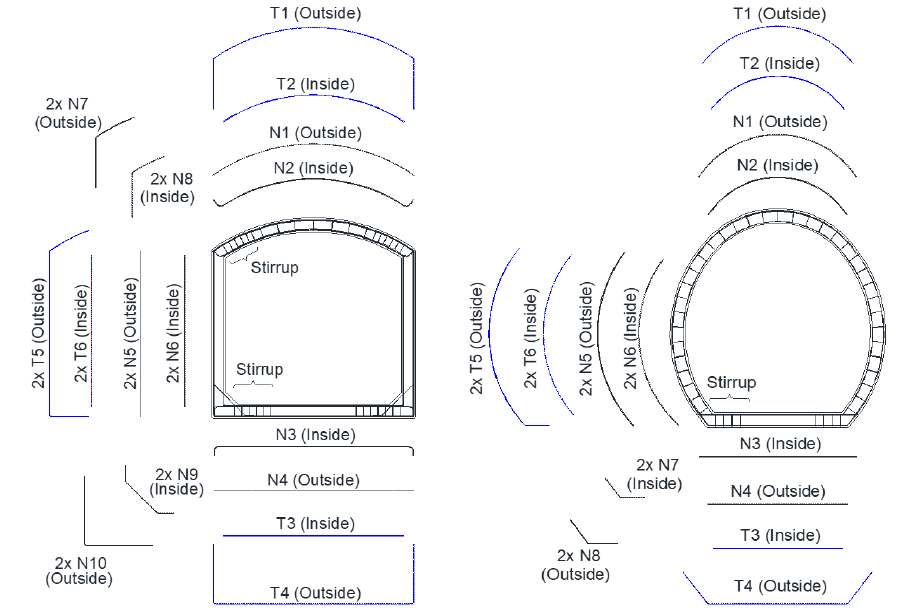
Figure 16. Reinforcement arrangement in culverts modified and defined by three